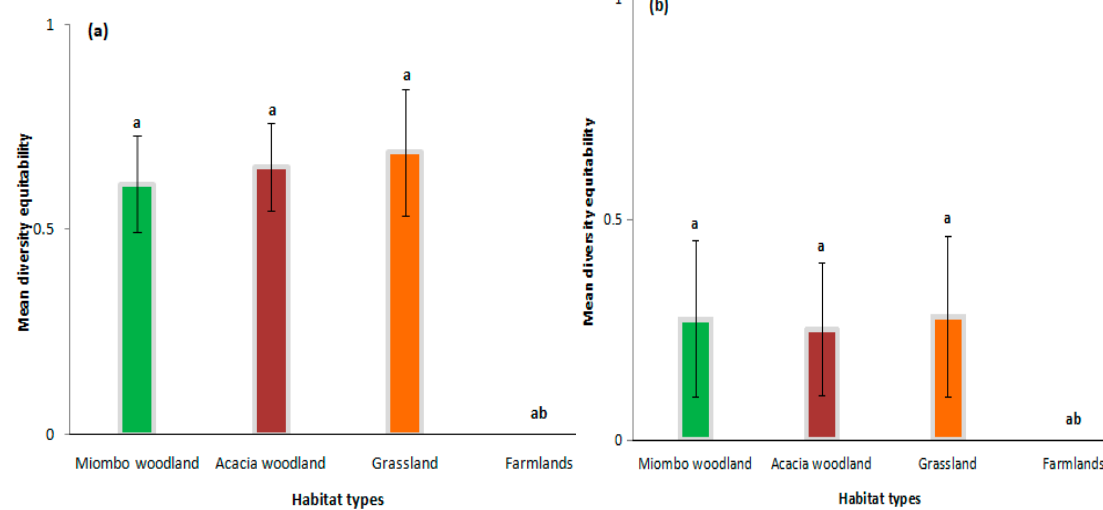
Figure 5. Mean diversity of rodents across different habitat types in Chembe Bird Sanctuary landscape, Zambia, in 2018–2019 in wet ( a ) and dry ( b ) seasons, respectively. The error bars represent the standard errors in the mean diversity of rodents. Letters a, b, and ab above the bar graphs denote significant differences of mean diversity of rodents among different habitat types.